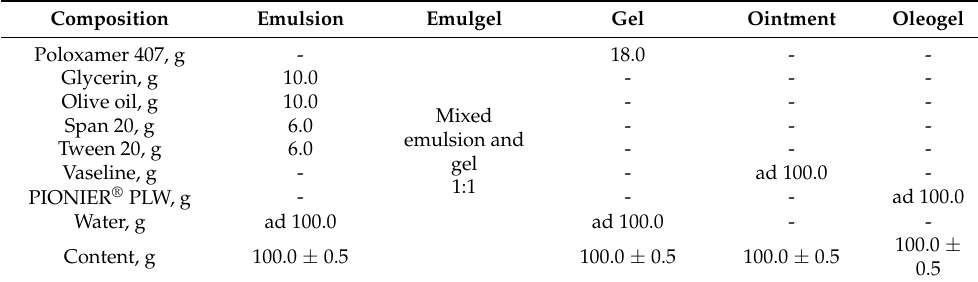
Table 1. Composition of the delivery systems.